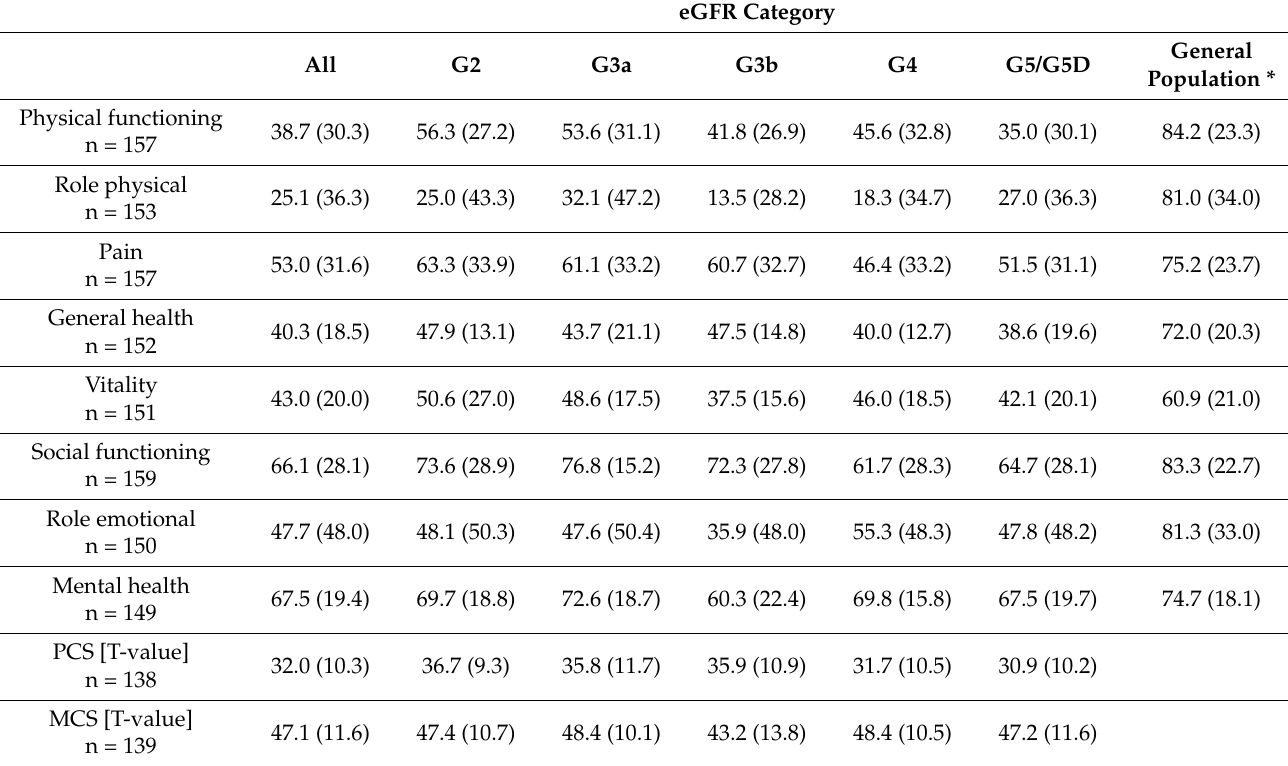
Table 3. SF-36 dimensions of functioning and composite scores. eGFR